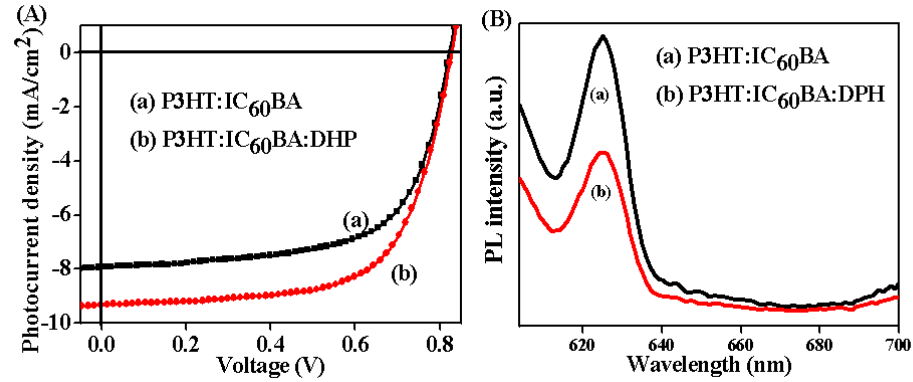
Figure 5. ( A ) J–V characteristics of the BHJ PSCs fabricated with (a) P3HT:IC 60 BA and (b)